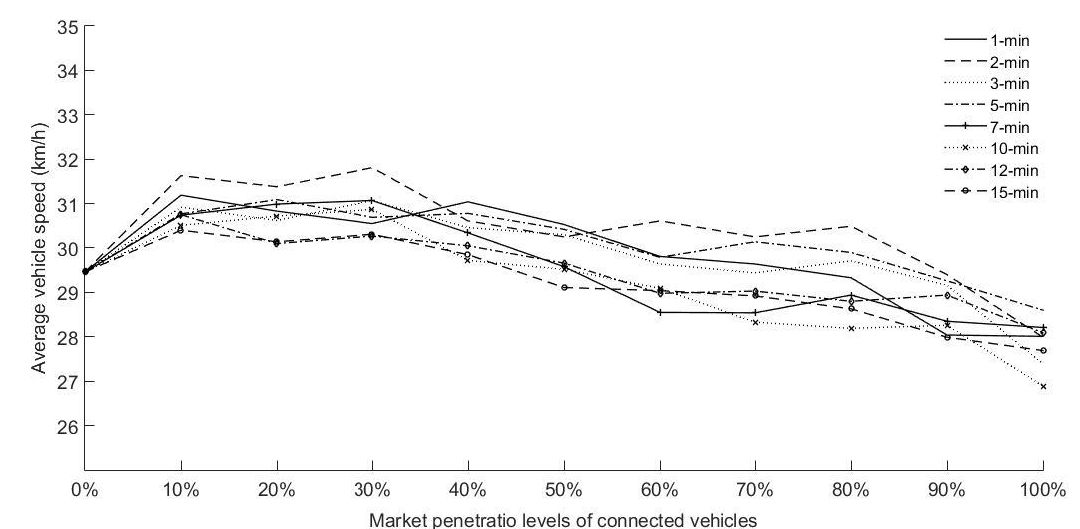
Figure 7. AVS for different update intervals on varying the market penetration level